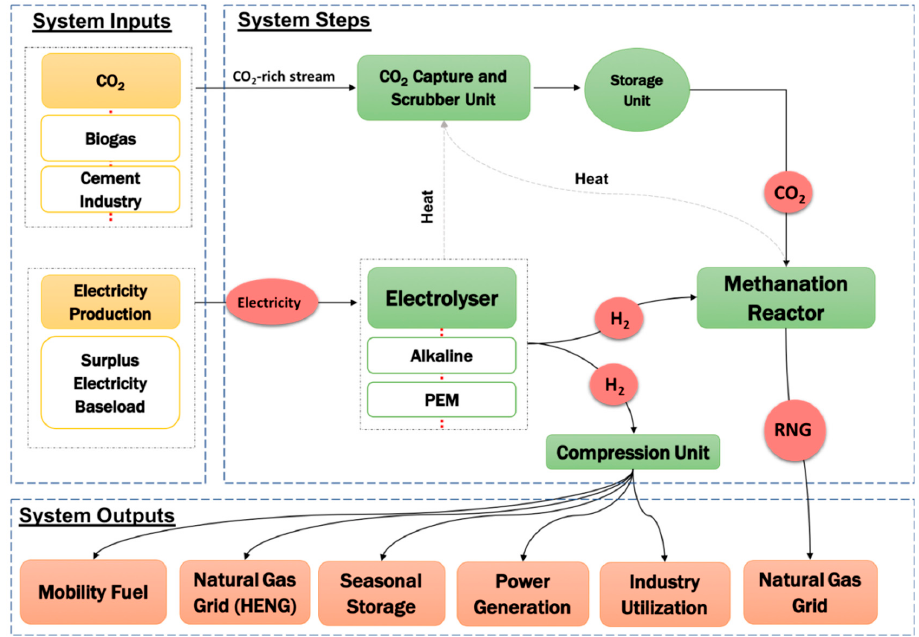
Figure 1. Power-to-Gas pathways.